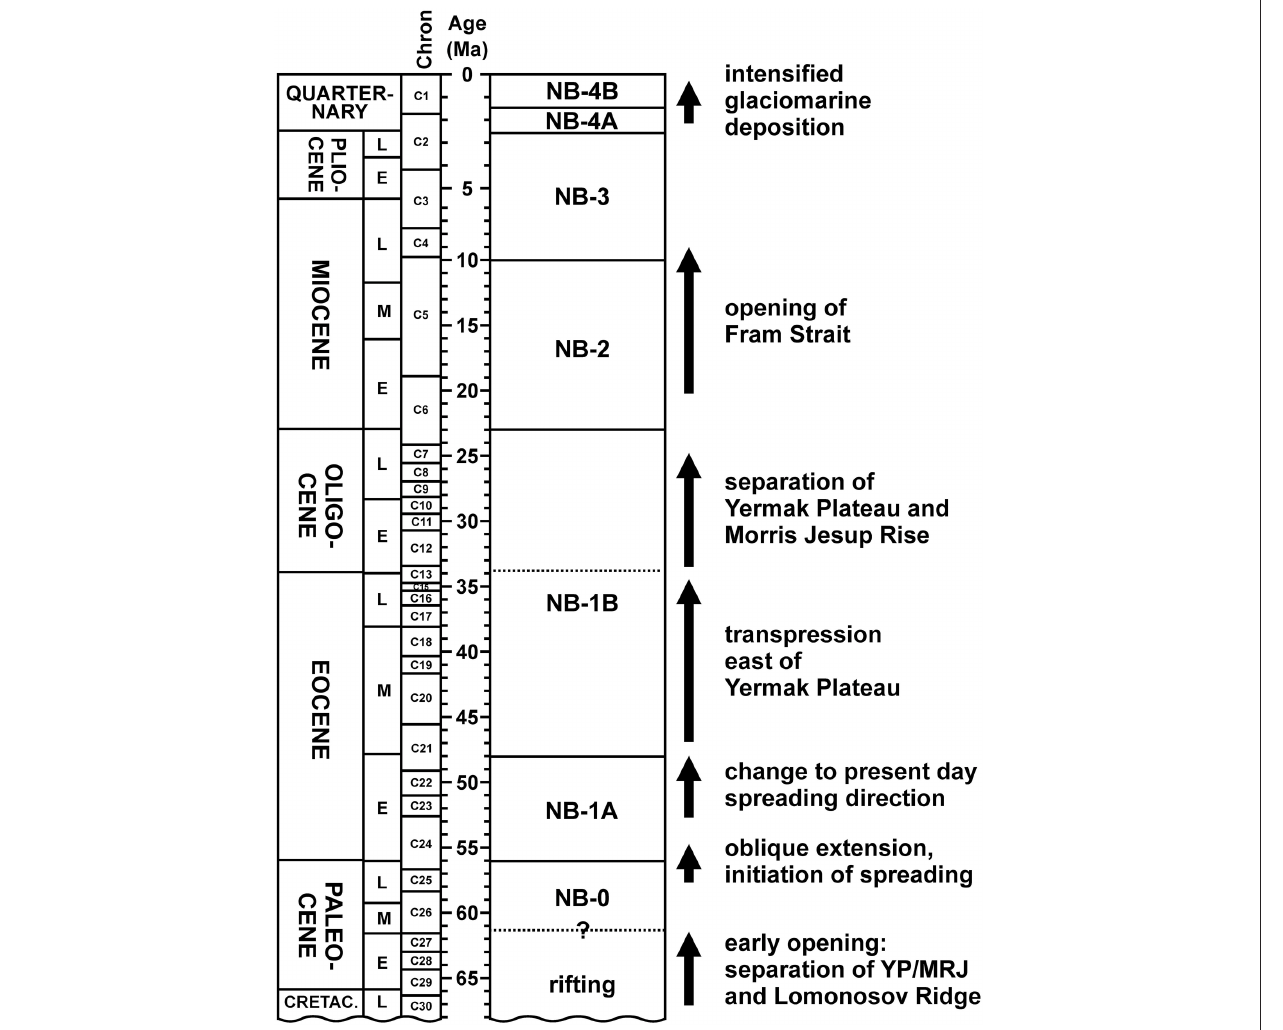
FIGURE 6 | Seismic stratigraphic framework of the westernmost Nansen Basin, and major events affecting the area (modified from Engen et al., 2009 ). YP, Yermak Plateau; MJR, Morris Jesup